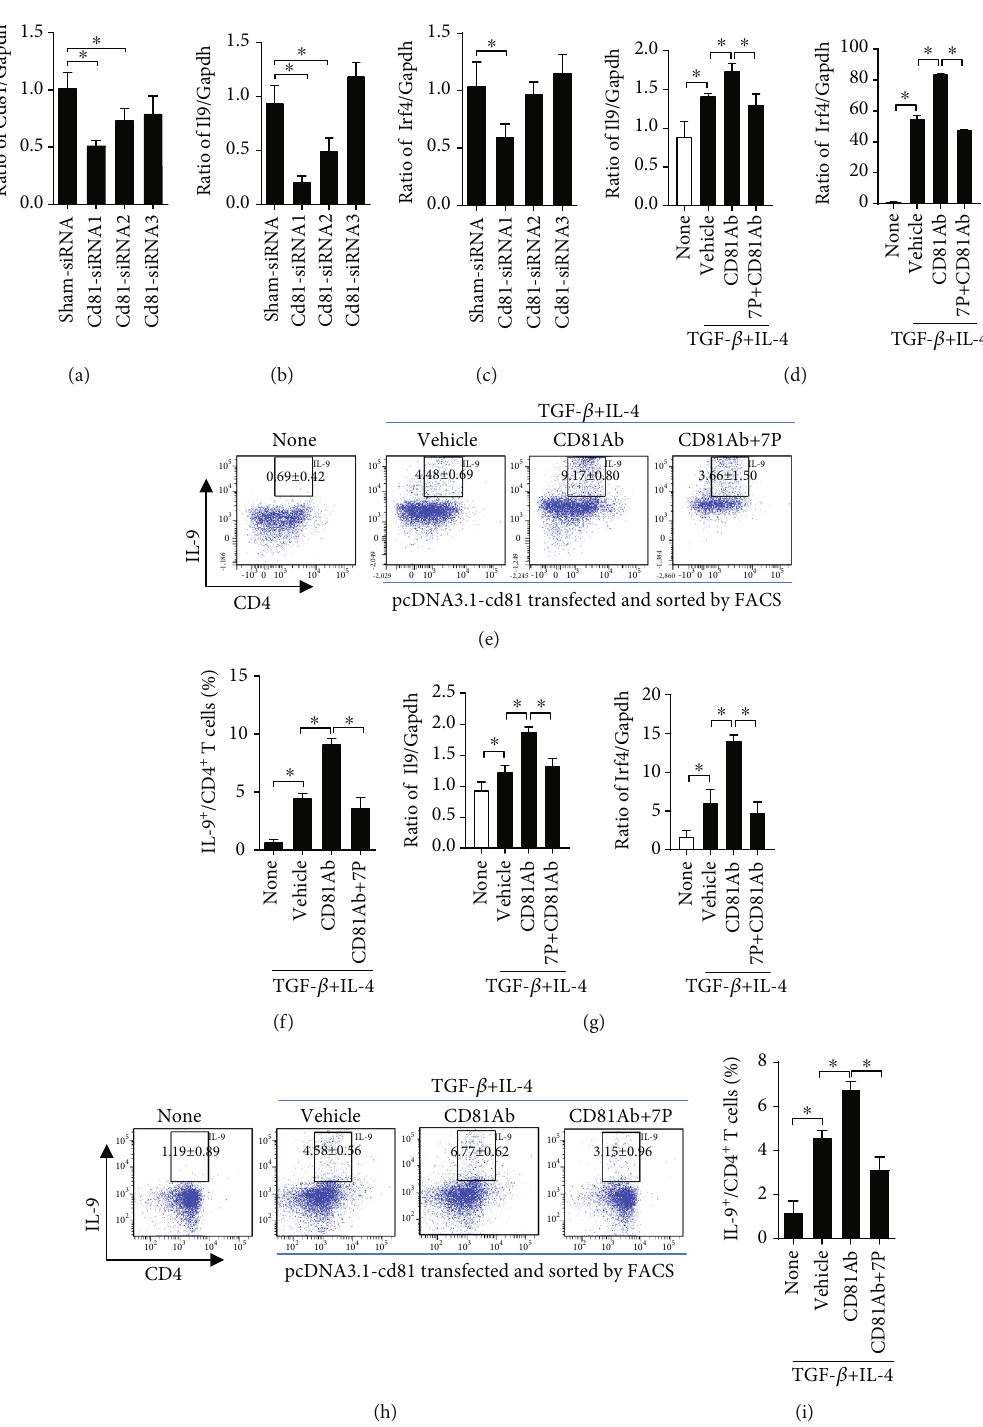
Figure 5: Inhibition of CD81 by siRNAs or 7P signi fi cantly reduces Th9 cell di ff erentiation from naïve CD4 + T cells. (a – c) Three CD81 siRNAs were transfected into naïve CD4 + T cells. Mouse naïve CD4 + T cells transfected with CD81 siRNAs were di ff erentiated into Th9 cells with anti-CD3 (3 μ g/mL), anti-CD28 (3 μ g/mL), anti-INF- γ (3 μ g/mL), TGF- β (10 ng/mL), and IL-4 (10 ng/mL) for 4 – 5 days. Cd81 , Il9 , and Irf4 mRNA were then examined in three CD81 siRNA-transfected cells and sham siRNA-transfected cells. Data are expressed as mean ± SEM ( n = 3 independent experiments). ∗ p < 0 : 05 compared with sham siRNA cells. The human cDNA-CD81 plasmid was successfully transfected into primary human peripheral blood naïve CD4 + T cells and the Jurkat cell line. Human CD81 overexpression dramatically promotes Th9 cell di ff erentiation in vitro in human primary naïve CD4 + T cells and the Jurkat cell line, as revealed by (d, f) qPCR and (e, g) FACS. (e, g) CD81 signaling was activated with an anti-CD81 antibody, and Th9 cell di ff erentiation was promoted in CD81-overexpressed human primary naïve CD4 + T and Jurkat cells. Anti-CD81 antibody during Th9 cell di ff erentiation is signi fi cantly inhibited by 7P in both overexpressed CD81 in human primary naïve CD4 + T and Jurkat cells ( n = 5 , ∗ p < 0 : 05